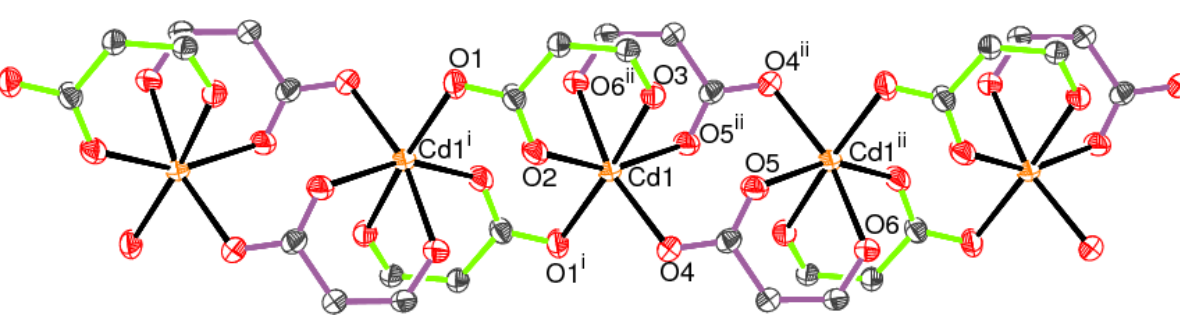
Figure 4. Fragment of a [100] polymeric chain in 1 showing only the O atoms and linking C atoms of the ligands (50% displacement ellipsoids; symmetry codes as in Table 1). The bonds of the C1 and C20 spar − anions are colored mint and plum, respectively.